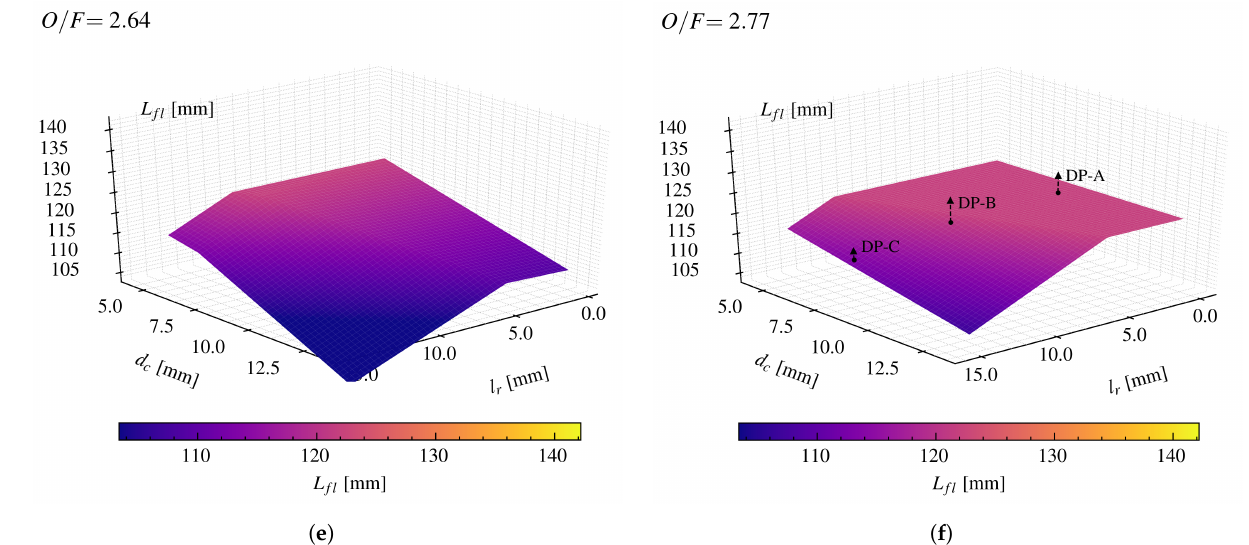
Figure 5. Design space navigation charts for global quantities: ( a , b ) c ∗ with the FCNNs indicated in Table 3 at mixture ratios ( O / F ) of 2.64 and 2.77. The l r and d c axis limits are those fixed for the DOE. In ( b , d , f ), ground truth LES values are marked by • and the FCNN prediction by (cid:78) . Their corresponding ground truth LES and FCNN are included in Table 6 for